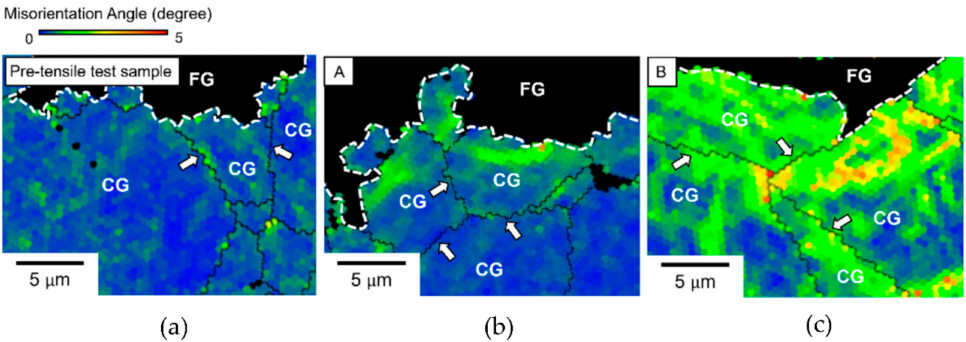
Figure 5. Magnified KAM maps at the shell–core boundary with a 0.5 µ m step size. FG and CG refer to the fine grains in the shell region and the coarse grains in the core region, respectively. The black regions in each figure referred to the FG which are not indexed. ( a ) Before the tensile test, the KAM is nearly homogenous. ( b ) After the tensile test, a higher KAM can be observed near the shell–core boundary than at the core–core boundary at position A. ( c ) At position B, a higher KAM can be observed at both the shell–core and core–core boundaries. The shell–core boundary is highlighted by the dashed white line, and the core–core boundaries are indicated by white